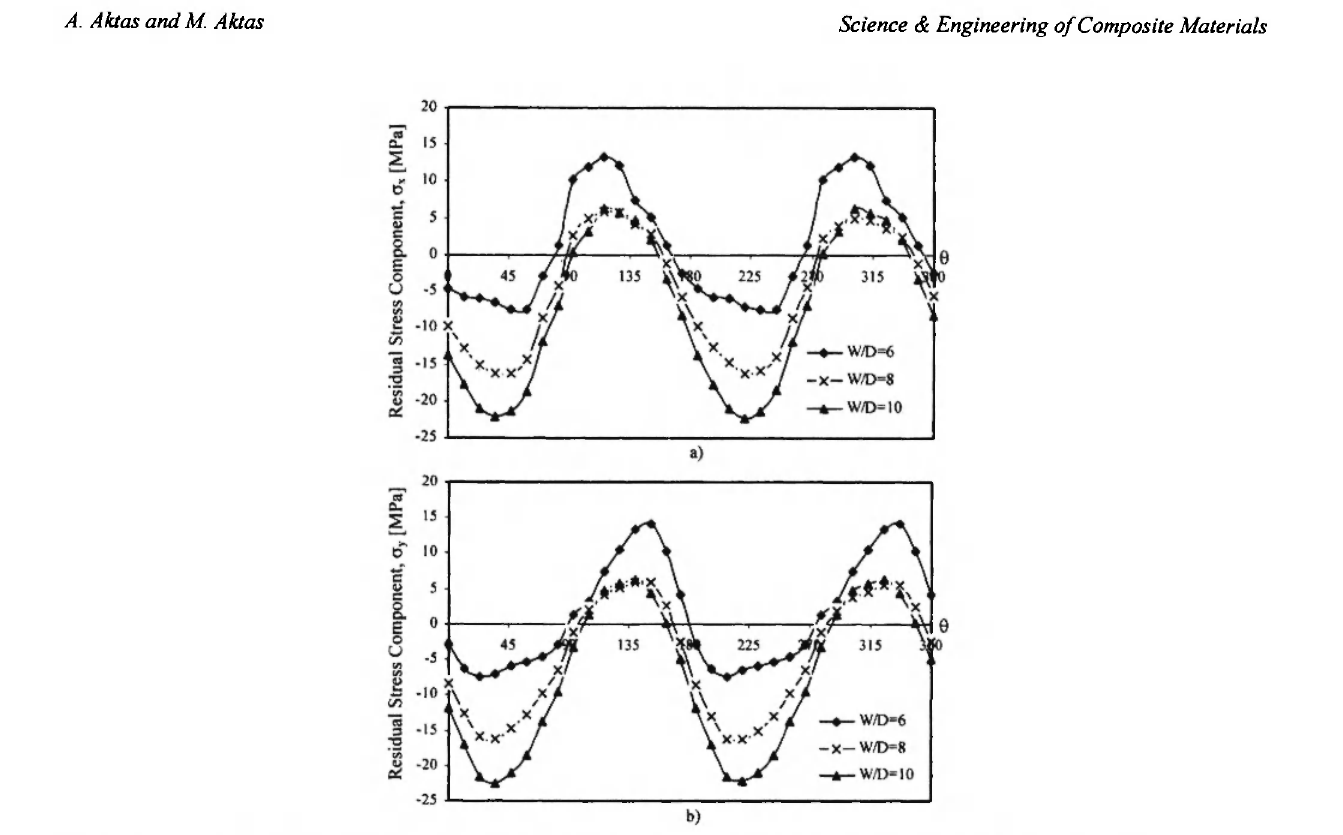
Fig. 8: Residual stress components at the border of the hole for angle-ply, [457-45°] s , laminated plates a) σ χ , b) σ.